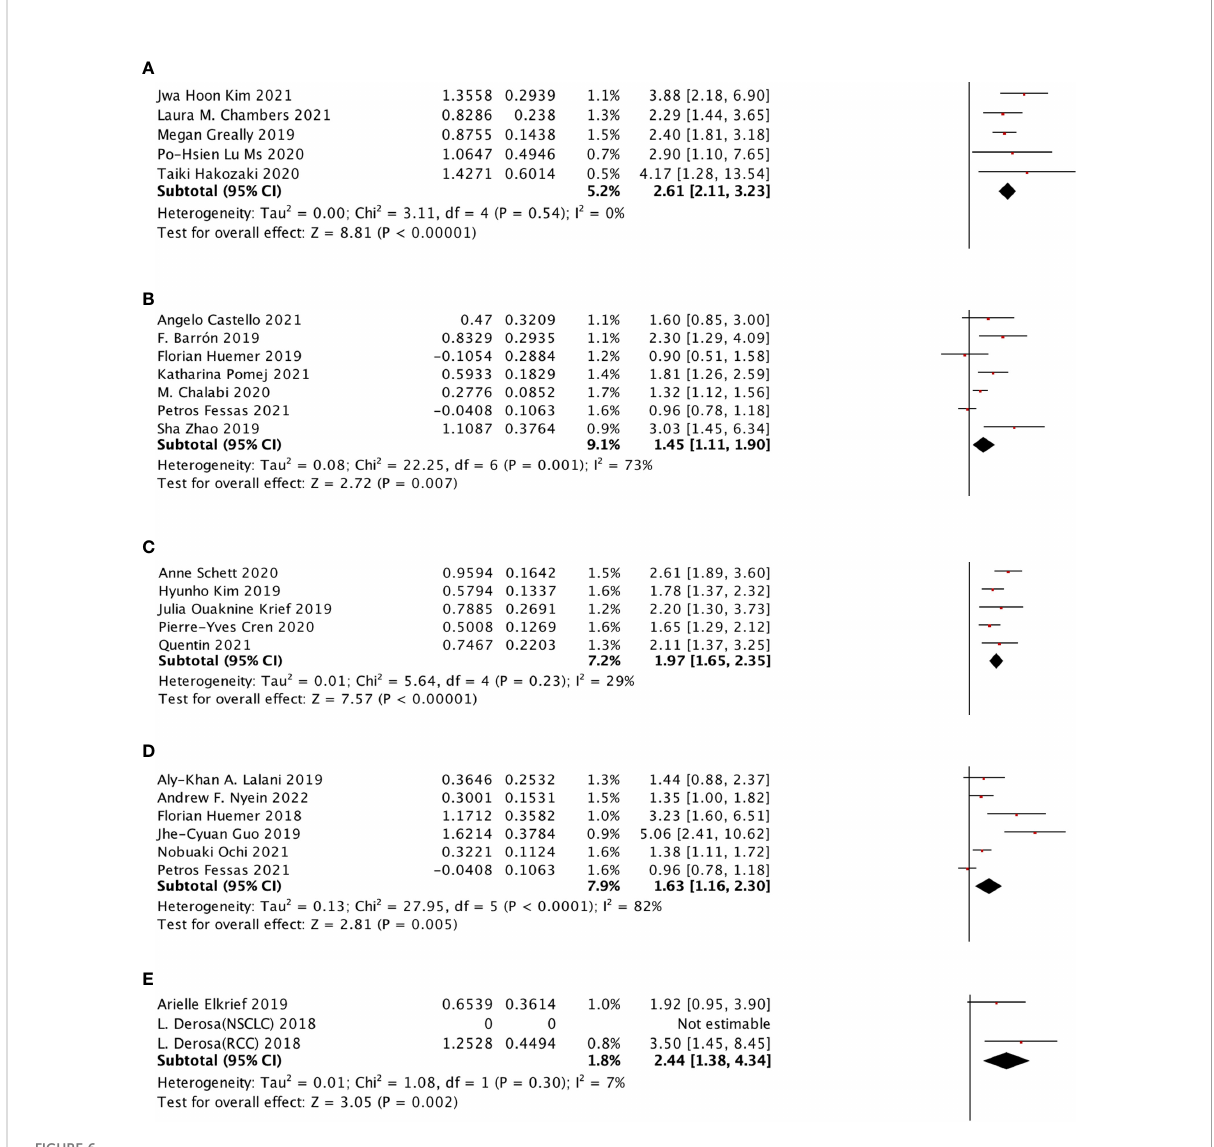
FIGURE 6 In different ATB windows, the subgroup analysis between ATB use and OS of cancer patients treated with ICIs. (A) ATB window ( − 30 days, 0 day); (B) ATB window ( − 30 days, 30 days); (C) ATB window ( − 60 days, 0 days); (D) ATB window ( − 60 days, 30 days); and (E) ATB window (0 days, 30